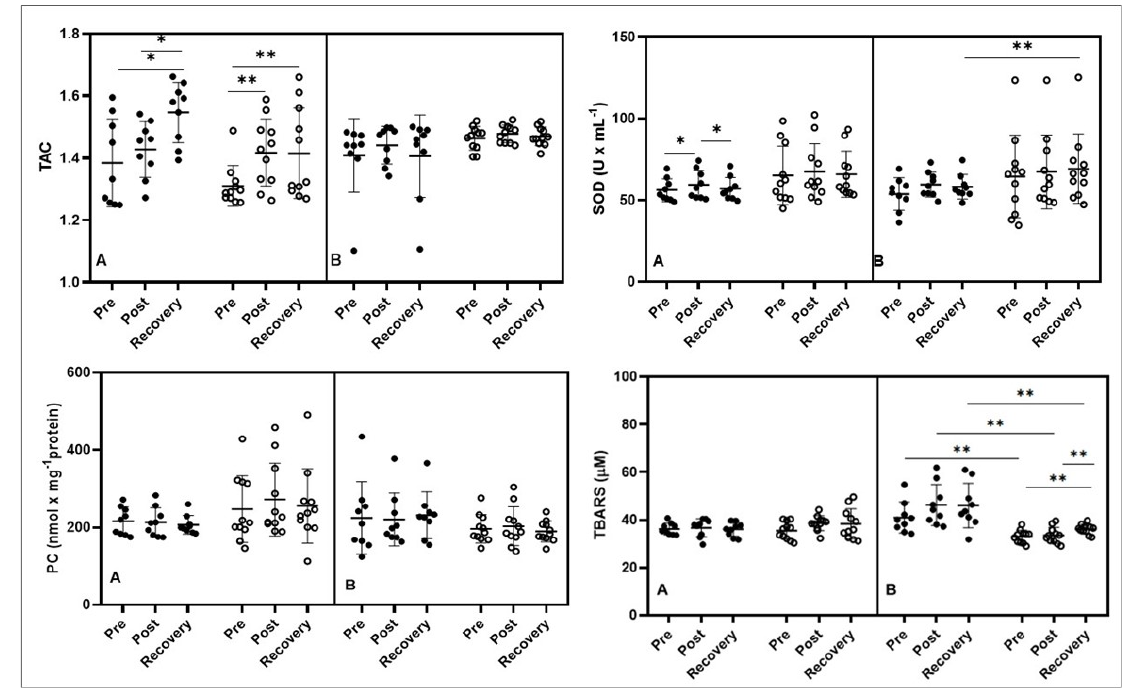
Figure 3. Effect of bovine colostrum supplementation on TAC—total antioxidant capacity; SOD— superoxide dismutase; PC—protein carbonyl; and TBARS—thiobarbituric acid reactive substances during exercise test performed before ( A ) and after supplementation ( B ). Note . Values are presented as mean ± SD; PLACEBO (black dots); COLOSTRUM group (white dots); * p < 0.05 ** p < 0.01; TAC total antioxidant capacity; SOD superoxide dismutase; PC protein carbonyl; TBARS thiobarbituric acid reactive substances.